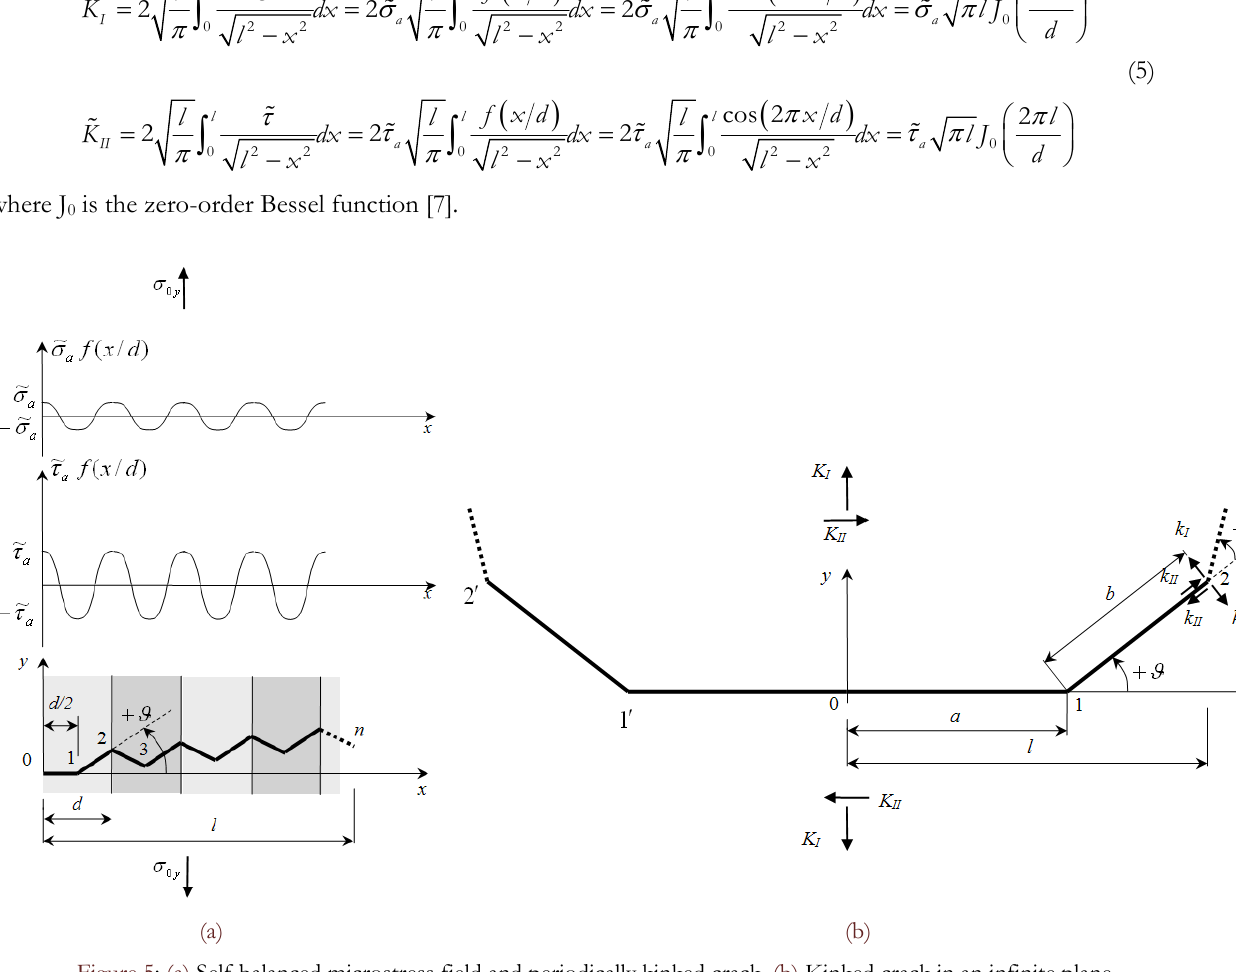
Figure 5: (a) Self-balanced microstress field and periodically kinked crack. (b) Kinked crack in an infinite